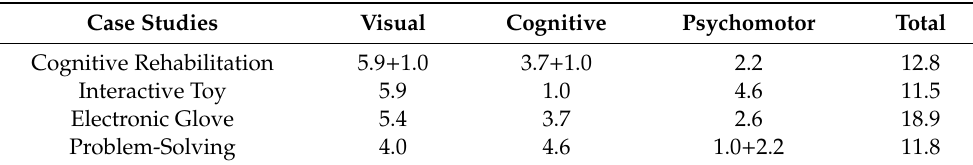
Table 2. Applying VACP for each case